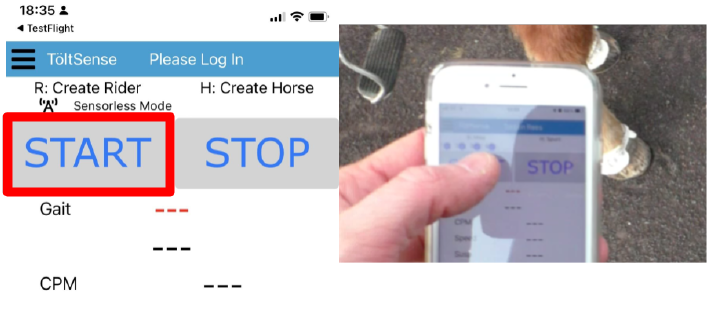
Figure 2. Töltsense interface and an example frame from a video of how the starting event was filmed with the press of the START button.